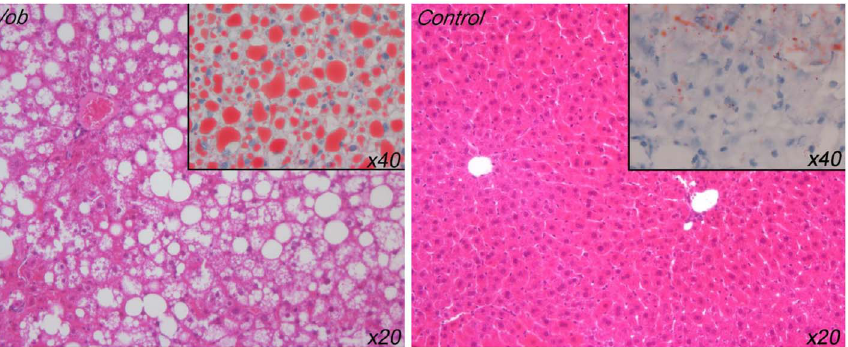
Figure 2. Liver tissue sections (4 m m) were stained for haemotoxylin and eosin (H&E, x20 magnification). Insets /sections (10 m m) were stained with Oil Red O (ORO, x40 magnification). Representative slides are displayed and ob/ob livers (left, n=9) showed severe macrovesicular steatosis on both H&E and ORO. Lean livers (right, n=9) showed no steatosis on H&E but ORO showed some patchy mild microvesicular steatosis.